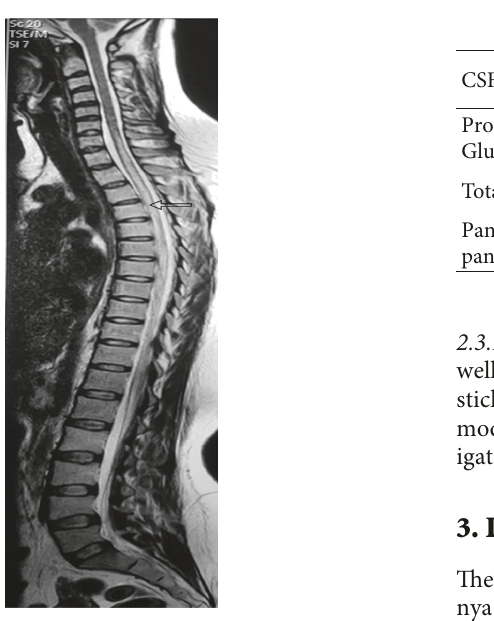
Figure 3: T2W sagittal image showing intramedullary hyper- intensity extending from C7–D9 segment (long-segment